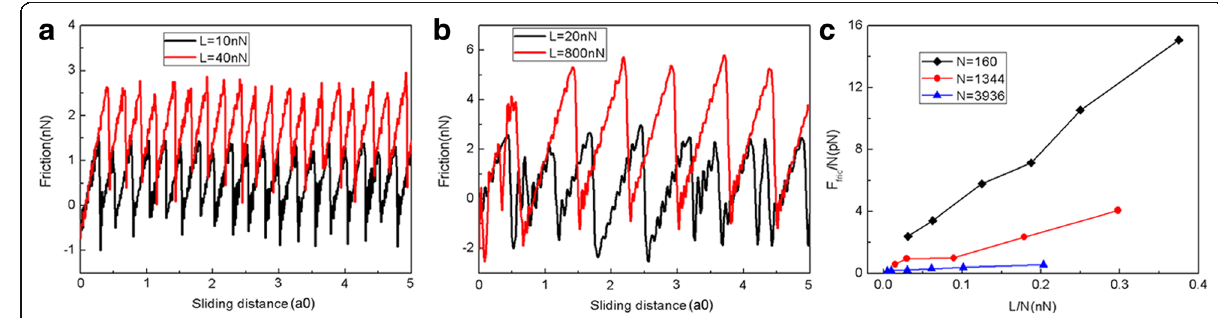
Fig. 3 The variation of friction force and average friction force for different flake sizes. The typical friction force as a function of sliding distance for the 2.0 nm ( N = 160 atoms) flake ( a ) and 10 nm ( N = 3936 atoms) flake ( b ). c The average friction force per atom ( F fric /N) as a function of load per atom (L/N). Here, a0 (= 9.99 Å) is the lattice spacing of Au(111) along the sliding